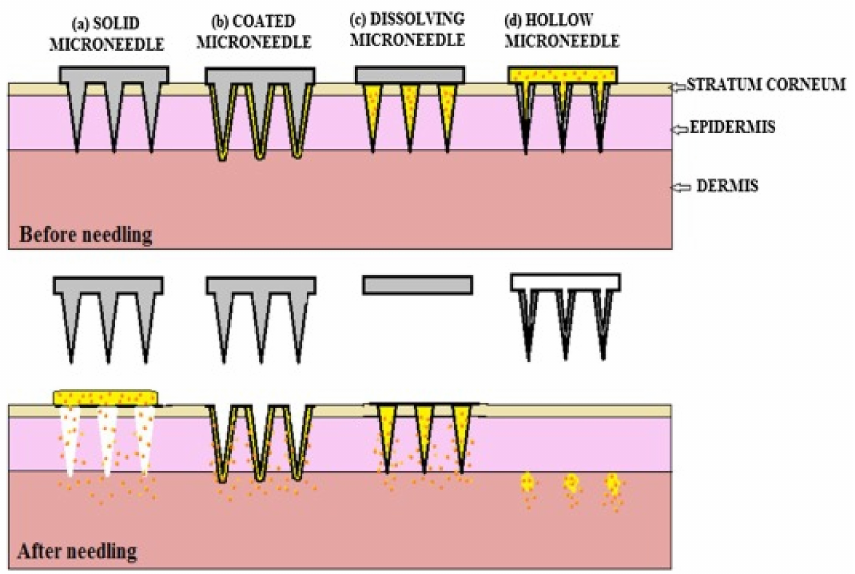
Figure 5. Different types of microneedles: ( a ) Solid microneedles with a poke with patch approach are used for pre-treatment of the skin. ( b ) Coated microneedles use the coat and poke approach, where a coating of the drug solution is applied on the needle surface. ( c ) Dissolving microneedles are made of biodegradable polymers. ( d ) Hollow microneedles are filled with the drug solution and deposit the drug in the dermis [16]. Reprinted from Biomedicine & Pharmacotherapy, Vol. 109, Tejashree Waghule et al., Microneedles: A smart approach and increasing potential for transdermal drug delivery system, Pages 1249–1258, Copyright (2019), with permission from